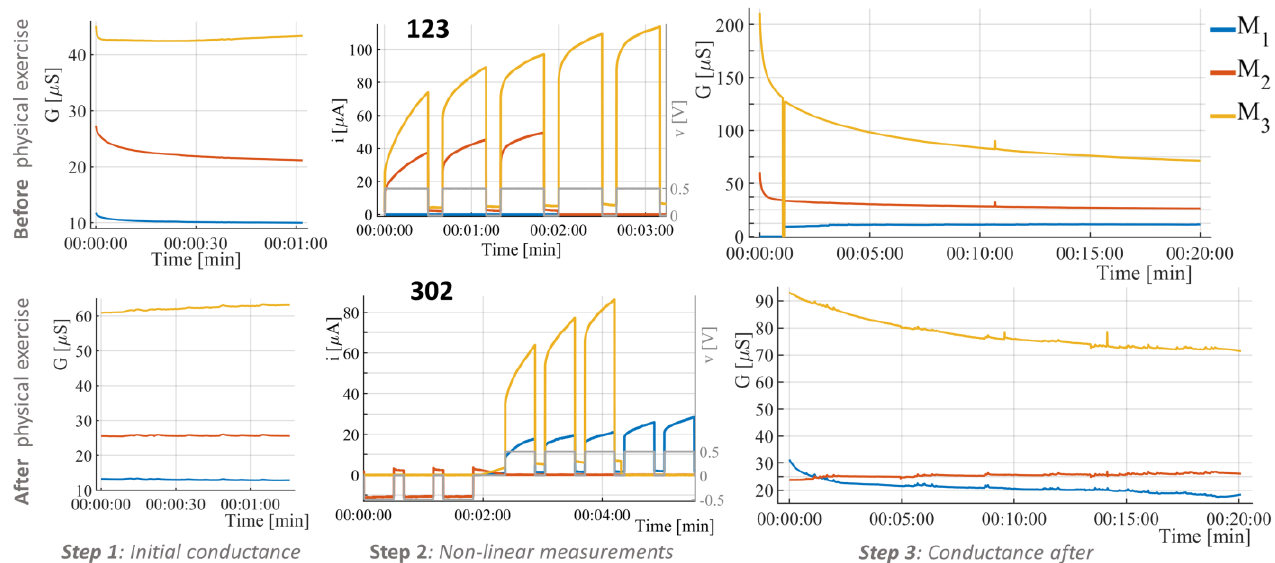
Fig. 3: Recordings of test subject “B” before (top plots, number 123 in this case) and after (bottom plots, number 302 in this case) physical exercise shown for the skin under all three measurement electrodes (M 1 , M 2 , and M 3 ). DC voltage pulses were applied (middle) and small signal conductance was measured before (left) and after (right) for around 1 minute, and 20 minutes, respectively. The drop of the conductance to zero under M 3 in the 20 minutes conductance measurement is an